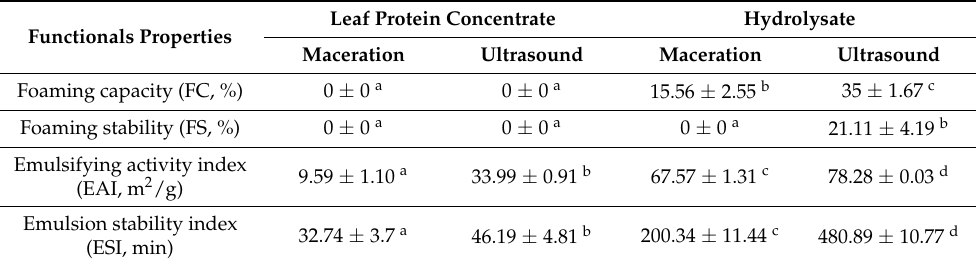
Table 3. Functional properties of leaf protein concentrate obtained by maceration and ultrasound and their